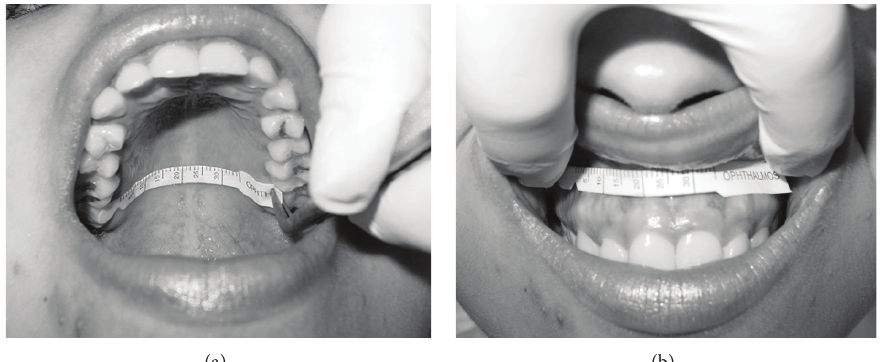
Figure 1: (a) Schirmer’s strip paper inserted over posterior palatal region. (b) Insertion of the Schirmer’s strip paper before placing the lip upon it to measure the saliva of the upper lip